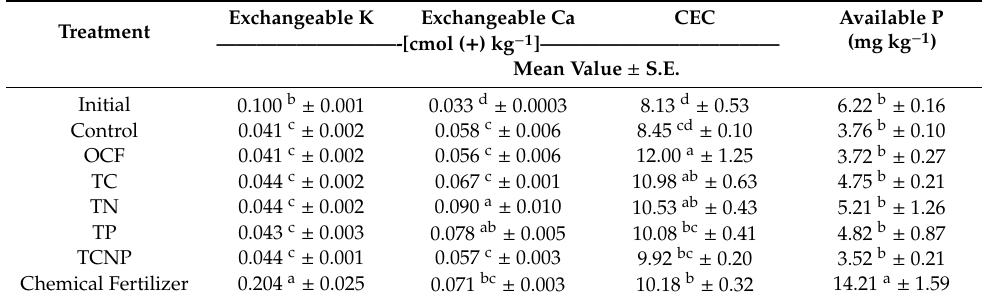
Table A2. E ff ect of treatments on soil exchangeable potassium, exchangeable calcium, cation exchange capacity and available phosphorus contents.